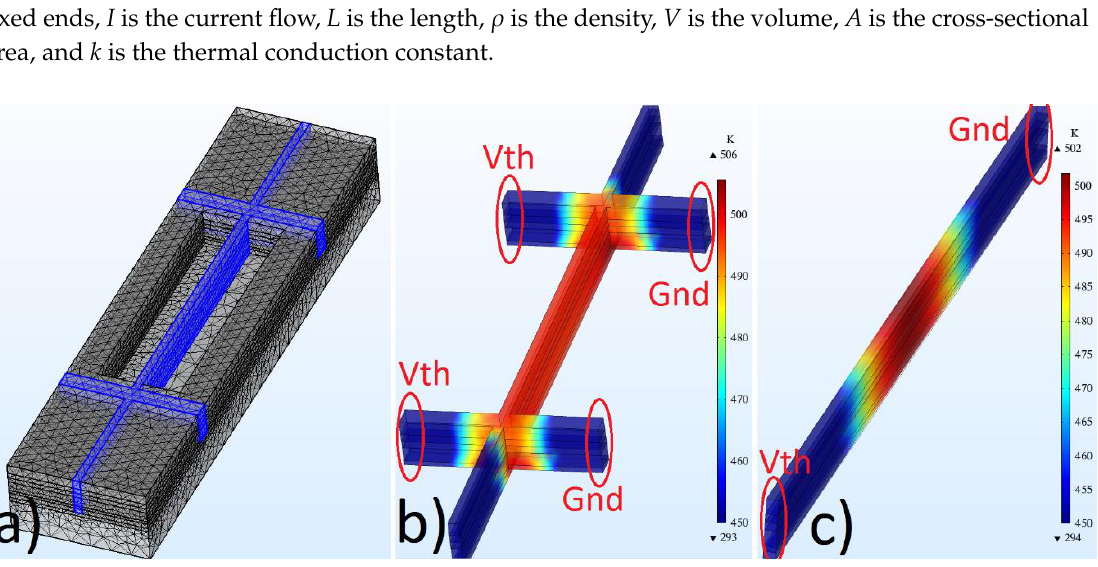
Figure 1. ( a ) UniJoule structure built via a CMOS process for performance improvement, and temperature distribution as a result of joule heating application of ( b ) UniJoule structure and ( c ) conventional clamped–clamped beam computed via COMSOL.